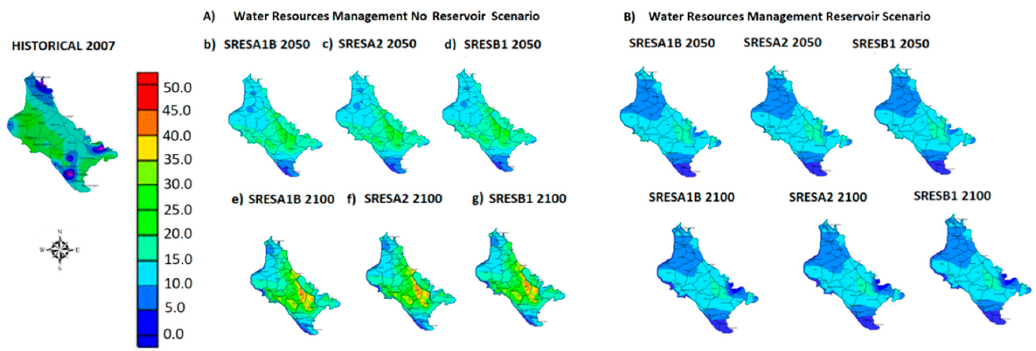
Figure 9. Maps of Nitrate concentration for the two water resources management and socio-economic scenarios: ( A ) SRES scenario of no-reservoir operational strategy; and ( B ) SRES scenario of reservoir operational strategy.